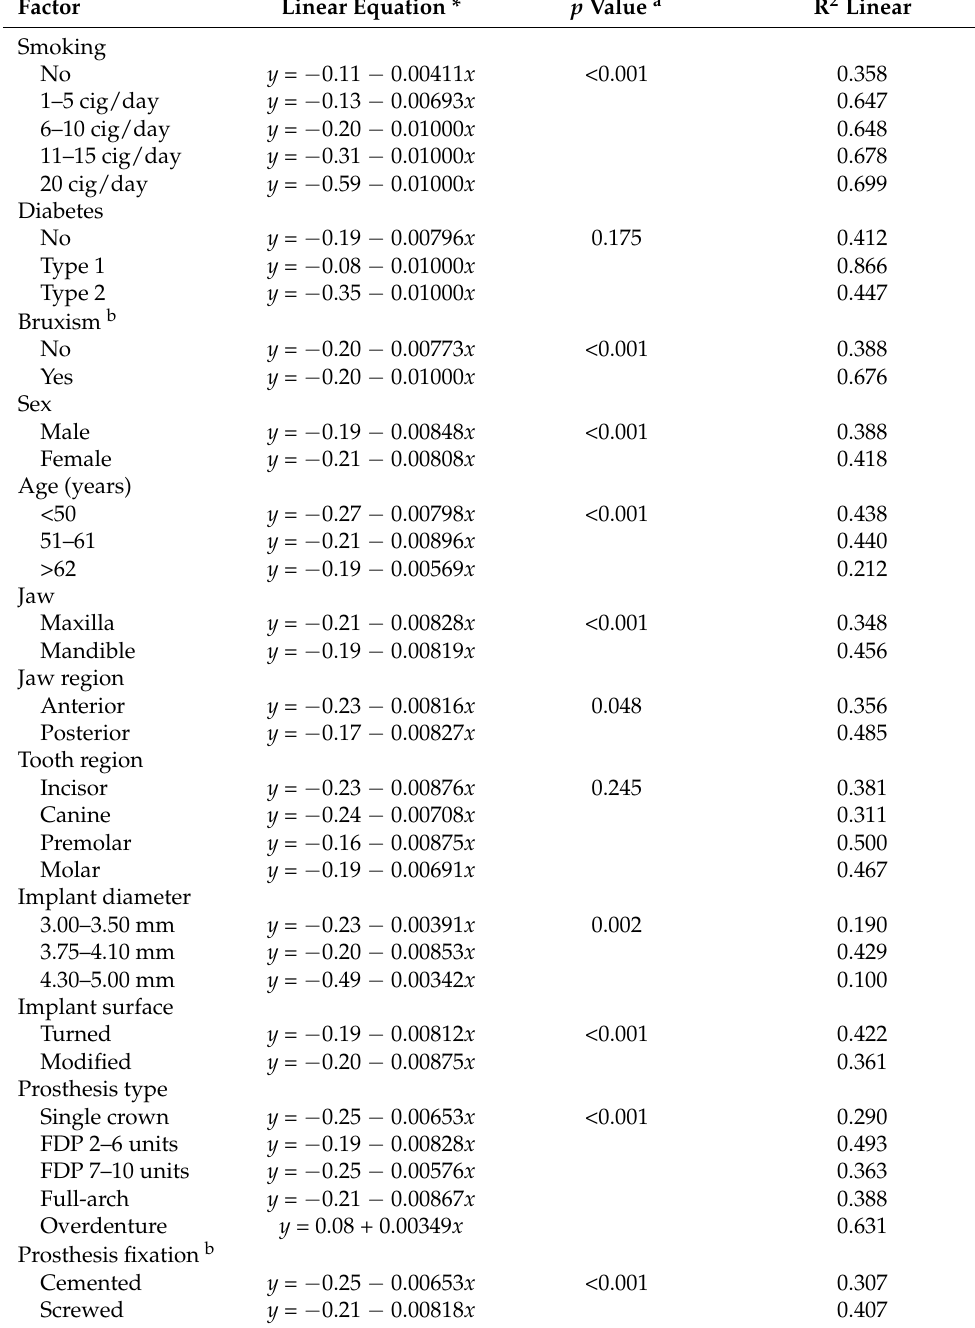
Table 3. Univariate linear regression analysis for